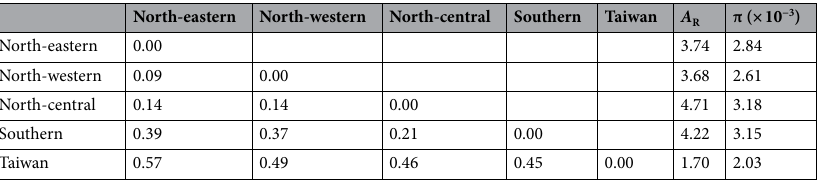
Table 2. Pairwised genetic differentiation ( F ST ) and genetic diversity as measured by π and haplotype richness, A R , among the five potential clusters as inferred by STRU CTU RE in low-copy nuclear genes (LCGs).